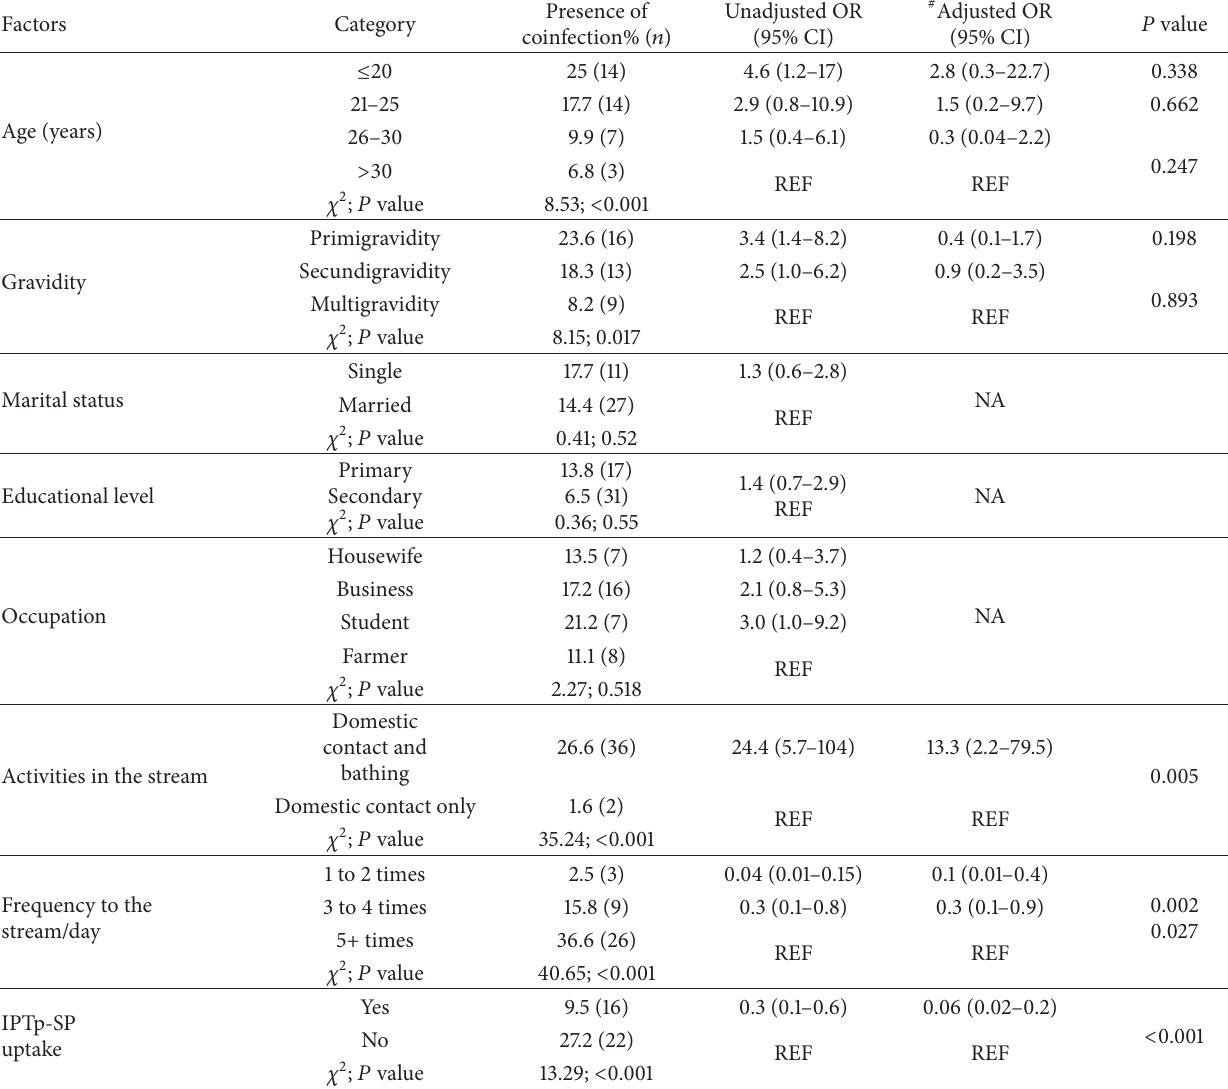
Table 3: Risk factors associated with coinfection with S. haematobium and P. falciparum among pregnant women in Munyenge.